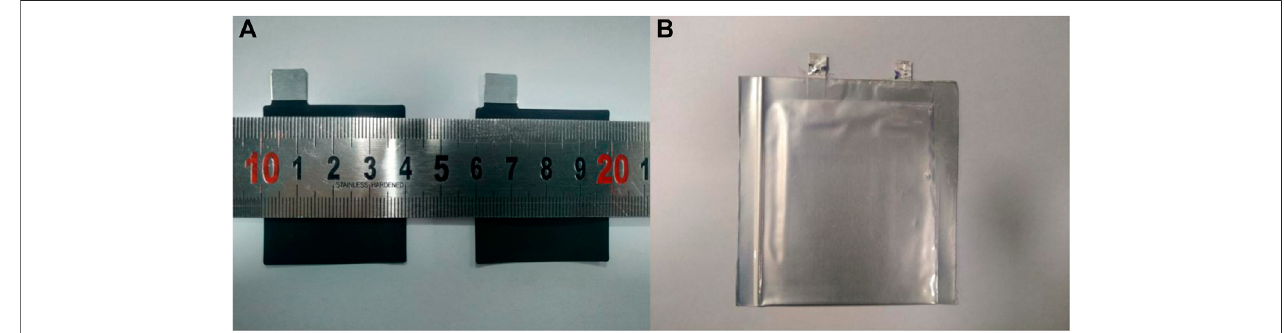
FIGURE 1 | Pictures of (A) the fabricated electrode and (B) the pouch-type EDLC.